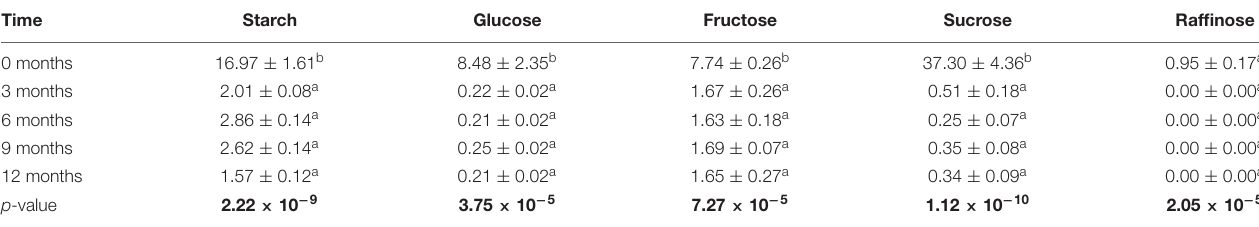
TABLE 1 | Non-structural carbohydrates (starch, glucose, fructose, and raffinose) contents in the sugarcane aging 12 months in the field.